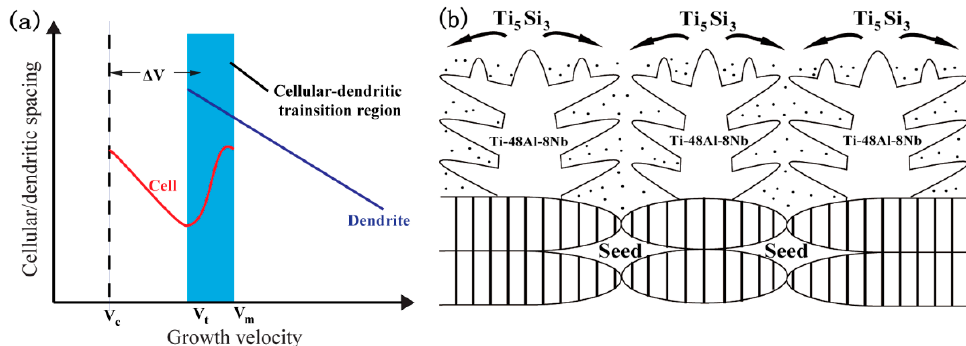
Figure 8. Effects of growth velocity and alloy elements on the interface morphology ( a ) and the illustration of interface transformation during the general seeding process ( b ). V c is the velocity after which the cellular interface forms, V t and V m are the velocity after which the cellular–dendritic transition starts and ends, respectively, and Δ V is the range of velocities in which only cellular interface can form.